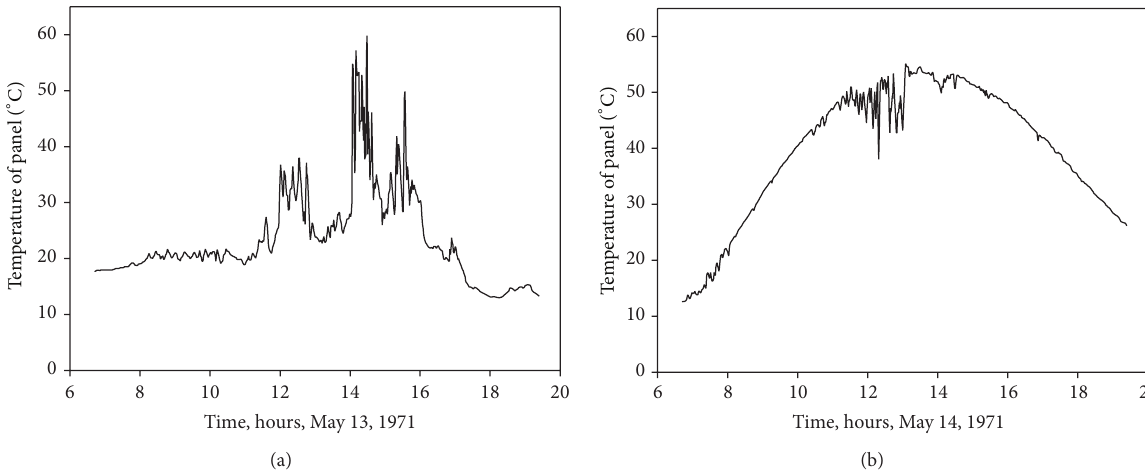
Figure 6: Solar panel temperatures on May 13, 1971 (a), and May 14, 1971 (b), at the Goddard Space Flight Center (GSFC). These graphs were calculated according to ambient conditions for those days; see Figure 5 and